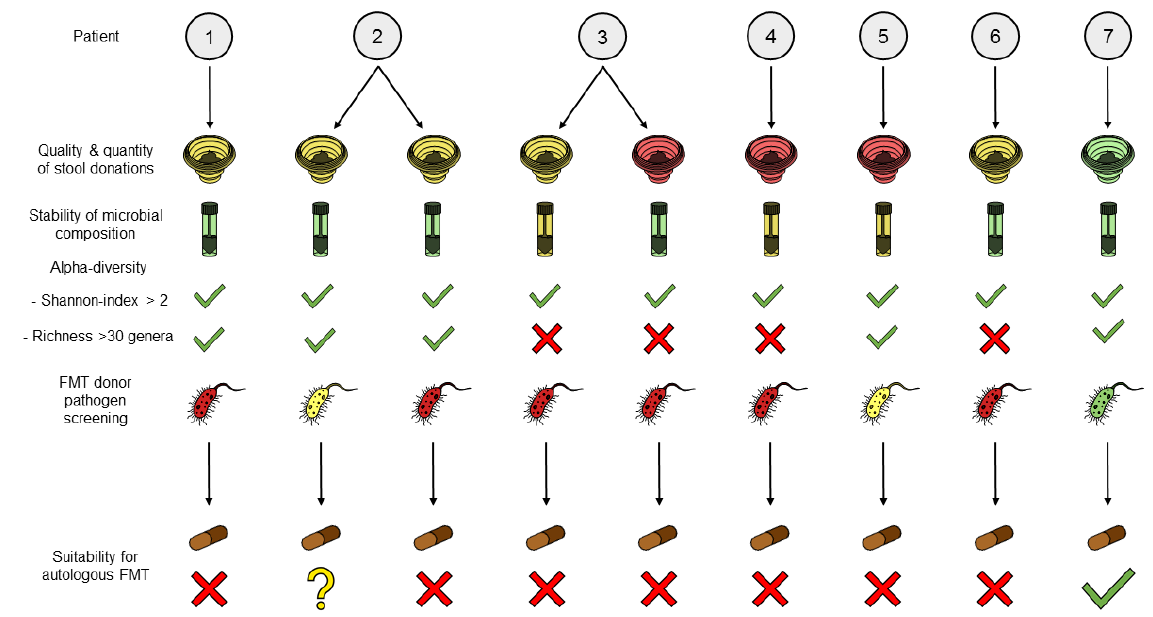
Figure 4. Suitability of stool donations from pediatric CD patients for autologous FMT. Numbers from 1 to 7 represent patients FMT-1 to FMT-7. Illustration of quality and quantity of stool donations (Fecotainer: green: standard requirements of FMT laboratory for FMT capsule production met, including fecal biomass >65 g, Bristol stool scale 3 – 4, and high alpha diversity, represented by Shannon index >2 and a richness above 30 genera, yellow: deviations of fecal weight and/or consistency and/or microbial richness, red: fecal weight and/or consistency insufficient resulting in failure to produce full batch of FMT capsules), stability of microbial composition during transport (Tube: green: comparable microbial composition and absolute abundance pre- and post-transport, yellow: increased absolute abundance of bacteria and/or significant changes in relative microbial composition at the genus level post-transport) and results from FMT donor pathogen screening (Bacterium: green: no pathogens detected, yellow: tolerable pathogens detected, and red: pathogens detected) for the nine FMT capsule production test runs.